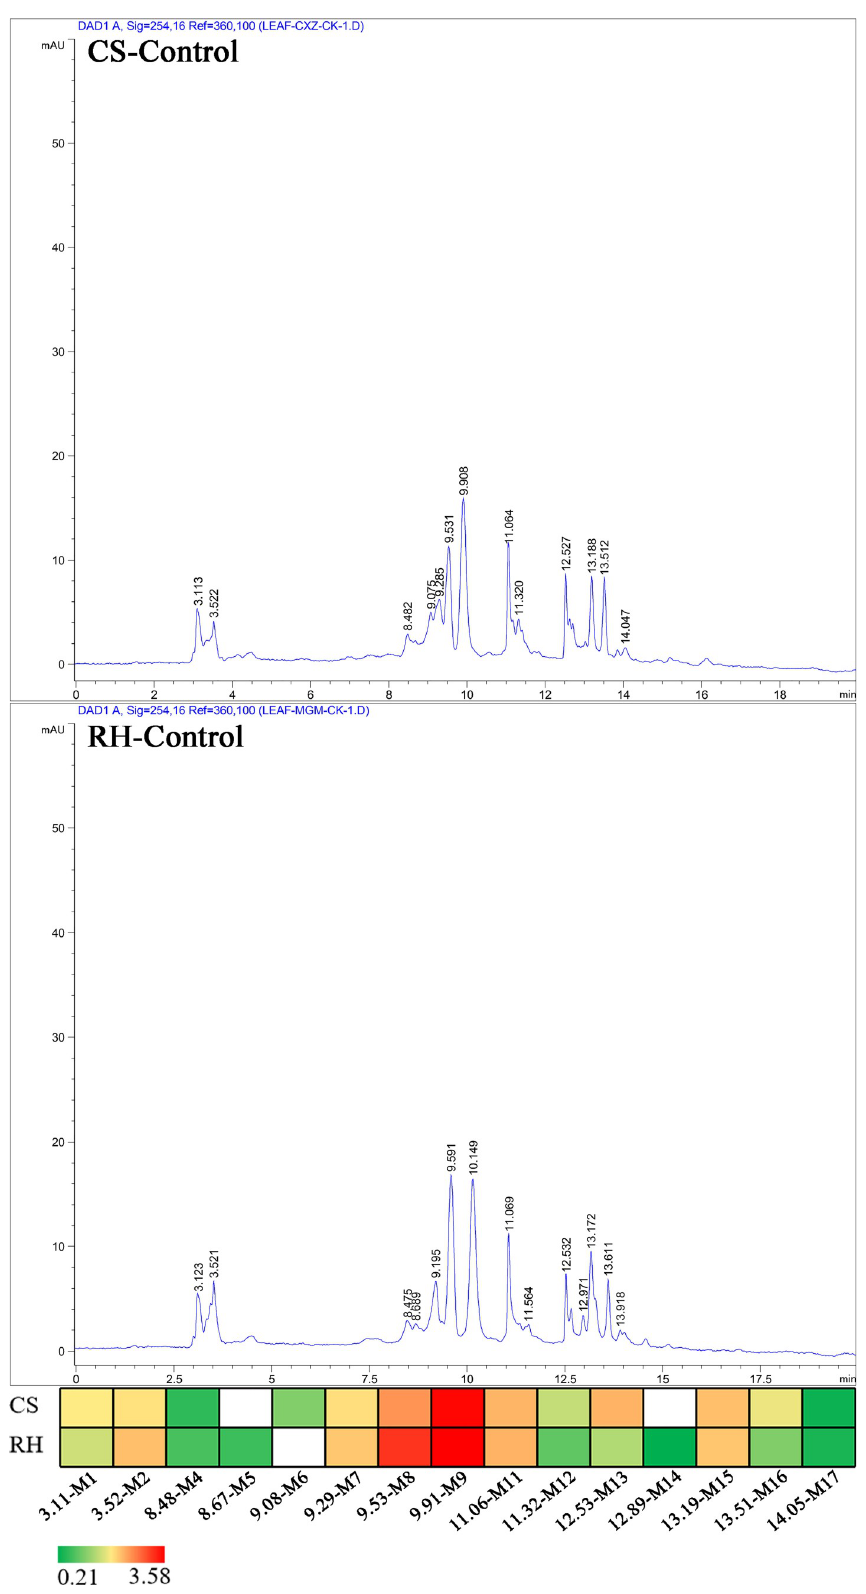
Fig 2. The basic metabolite profiles of CS and RH grape leaves using HPLC assays. https://doi.org/10.1371/journal.pone.0238734.g002 PLOS ONE | https://doi.org/10.1371/journal.pone.0238734 September 11,